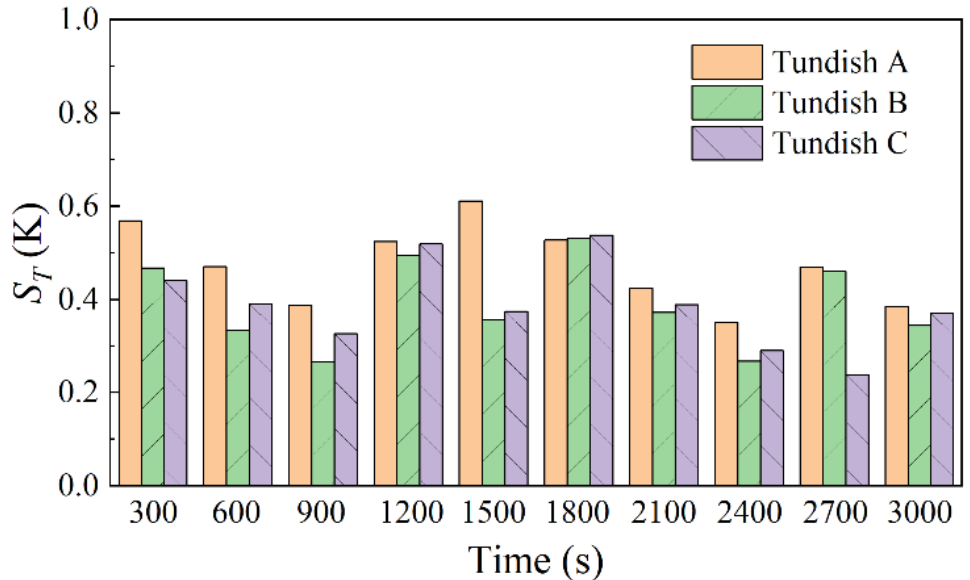
Figure 16. Standard deviation of molten steel temperature distribution in distributing chamber when tapping temperature of molten steel gradually drops.